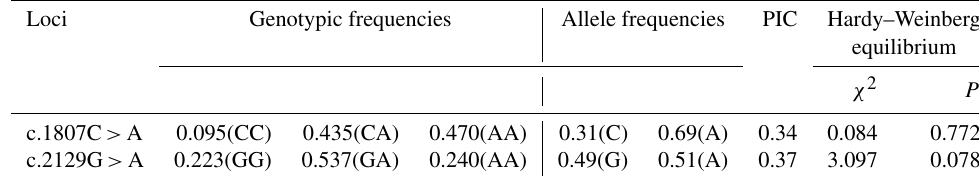
Table 3. Analysis of different genotype populations at MLPH gene mutation sites.